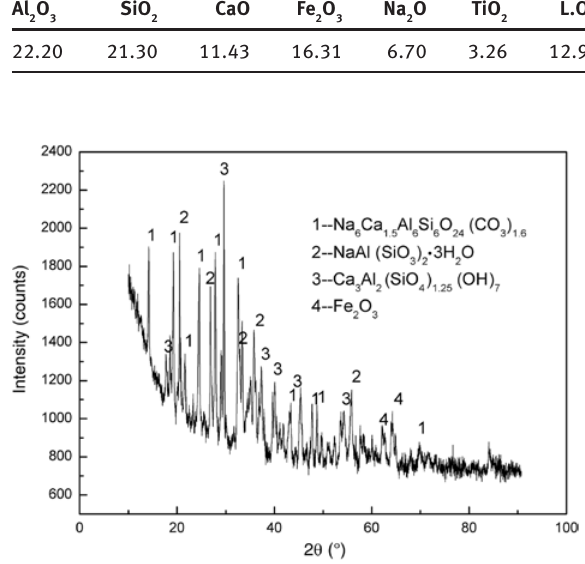
Figure 3: X-ray diffractogram of red mud used in experiments.